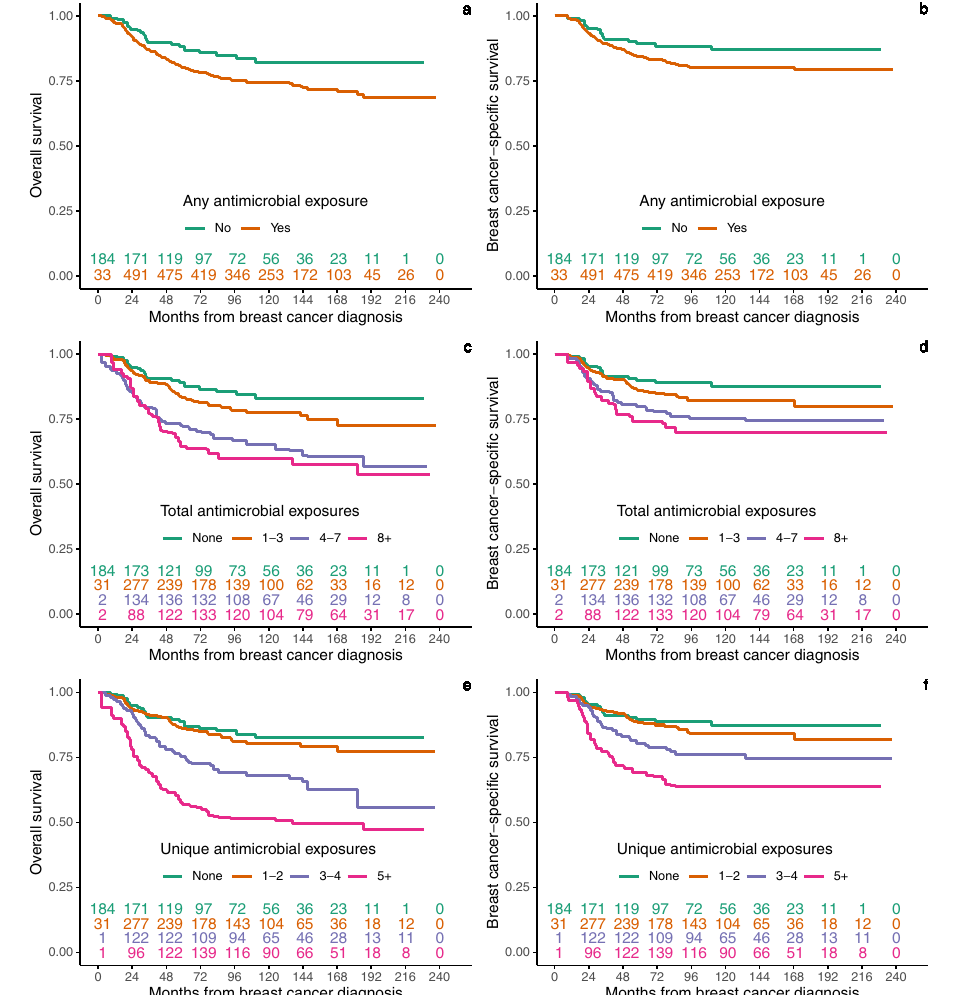
Fig. 2 | Weighted Kaplan – Meier estimates ofoverall and breast cancer-speci fi c survival by any, total, and unique number of antimicrobial exposures for N =772independentpatients.a , b Overallsurvival(OS)andbreastcancer-speci fi c survival(BCS)estimates forany antimicrobialexposure. c , d OSand BCSestimates